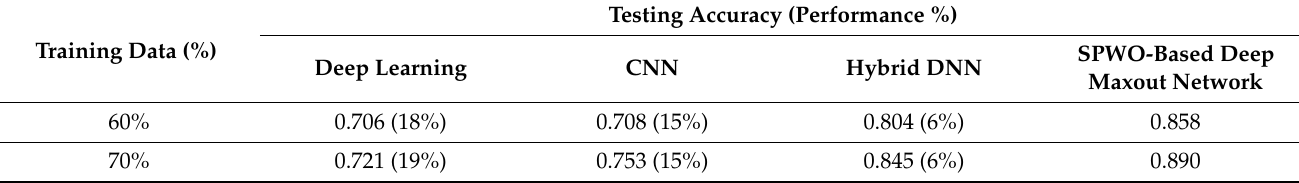
Table 3. The Analysis of Testing